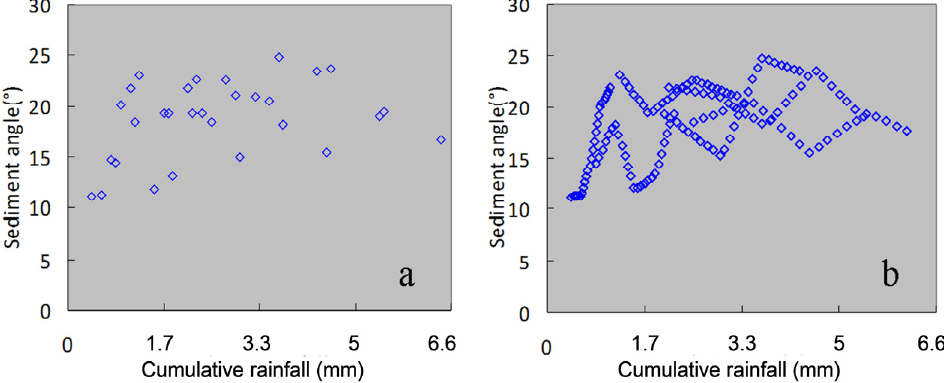
Figure 13. Cumulative rainfall with sediment angle. ( a ) Sediment angle with cumulative rainfall ( n = 29) based on physical tests; ( b ) sediment angle with cumulative rainfall ( n = 147) based on random field.